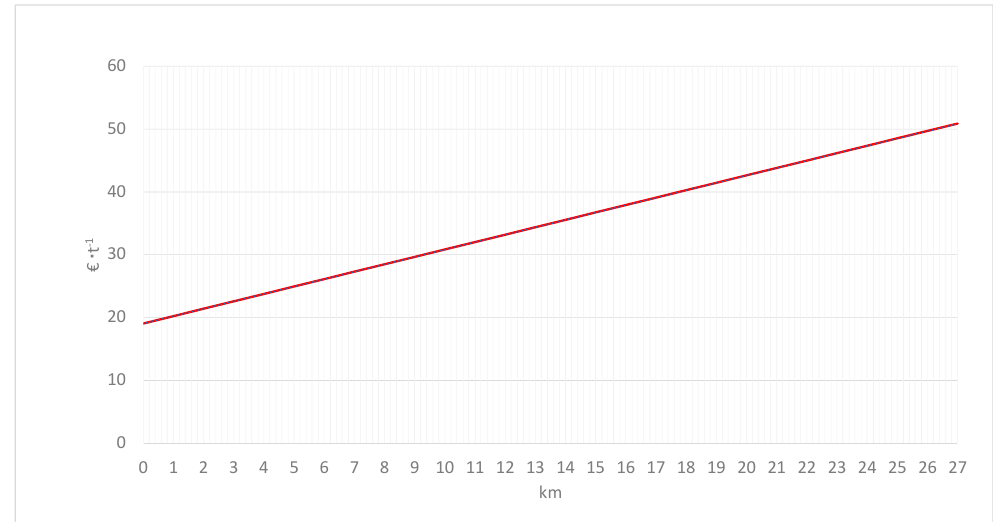
Figure 5. Economic thresholds of the transport of the pruning comminuted product of the Caravaggi mod. BIO900 in Italy (Calimera, LE).